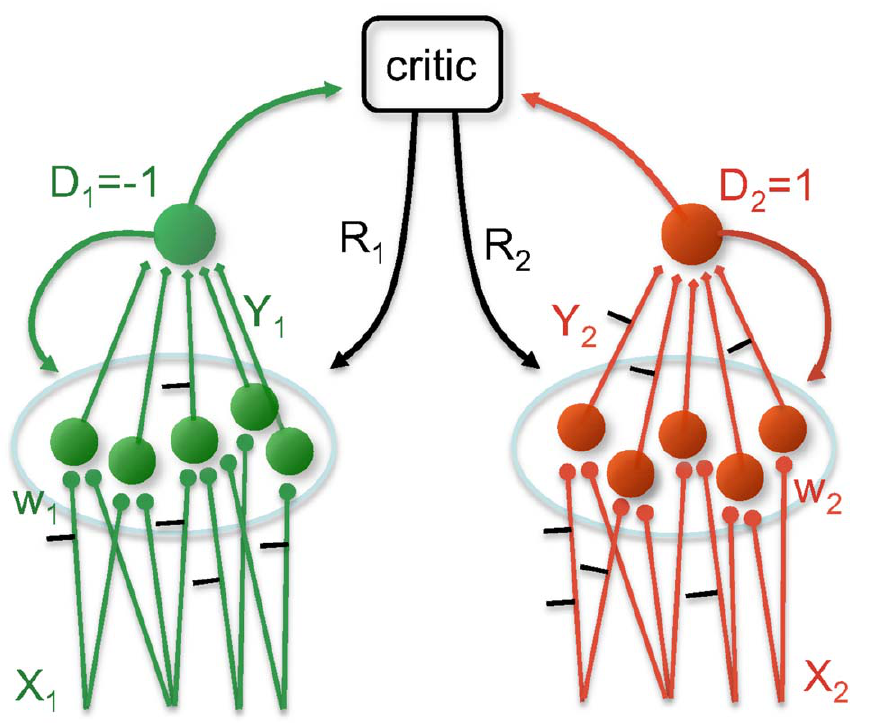
Figure 1. Neuronal architecture implementing the two players. Each player i ( ~ 1,2 ) is represented by a population of decision making neurons (shown 5 of each) which receive an input spike pattern X i and generate an output spike pattern Y i . The population decision D i ~ + 1 is represented by a readout unit, with D i ~ 1 being more likely when more decision making neurons fire at least one output spike. The synaptic weights w i are adapted as a function of X i , Y i , D i and the reward signal R i delivered by a critic.